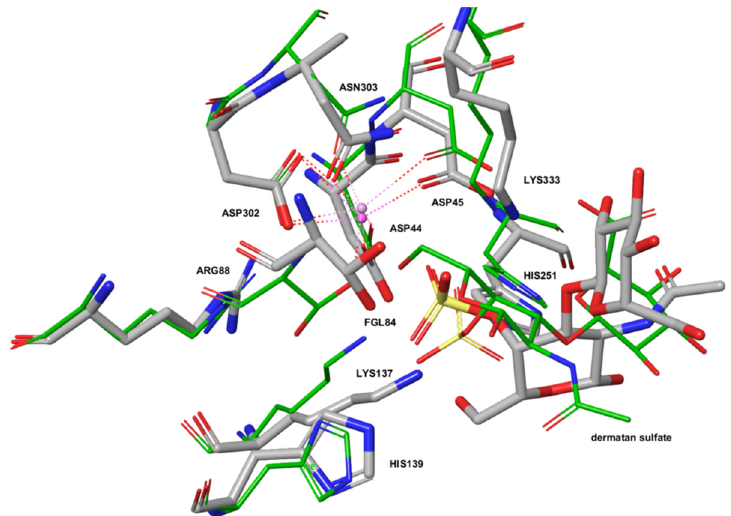
Figure 5. Comparison of binding modes of dermatan sulfate IdoA(a1-3)b-GalNAc4S to ARSB (PDB ID: 1FSU) shown in green and to ARSG (homology model) shown in gray. Marked in red are oxygen atoms, marked in blue are nitrogen atoms.